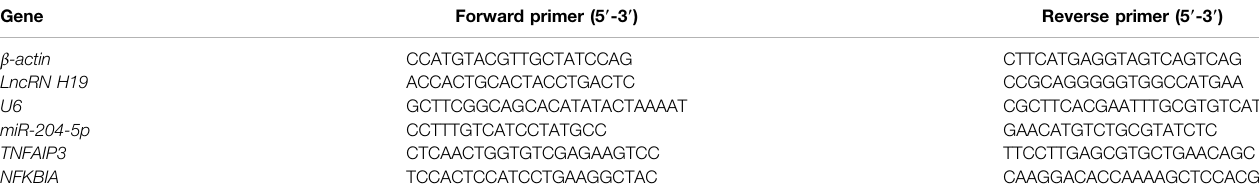
TABLE 2 | Primer sequences used for qPCR assay in mice.